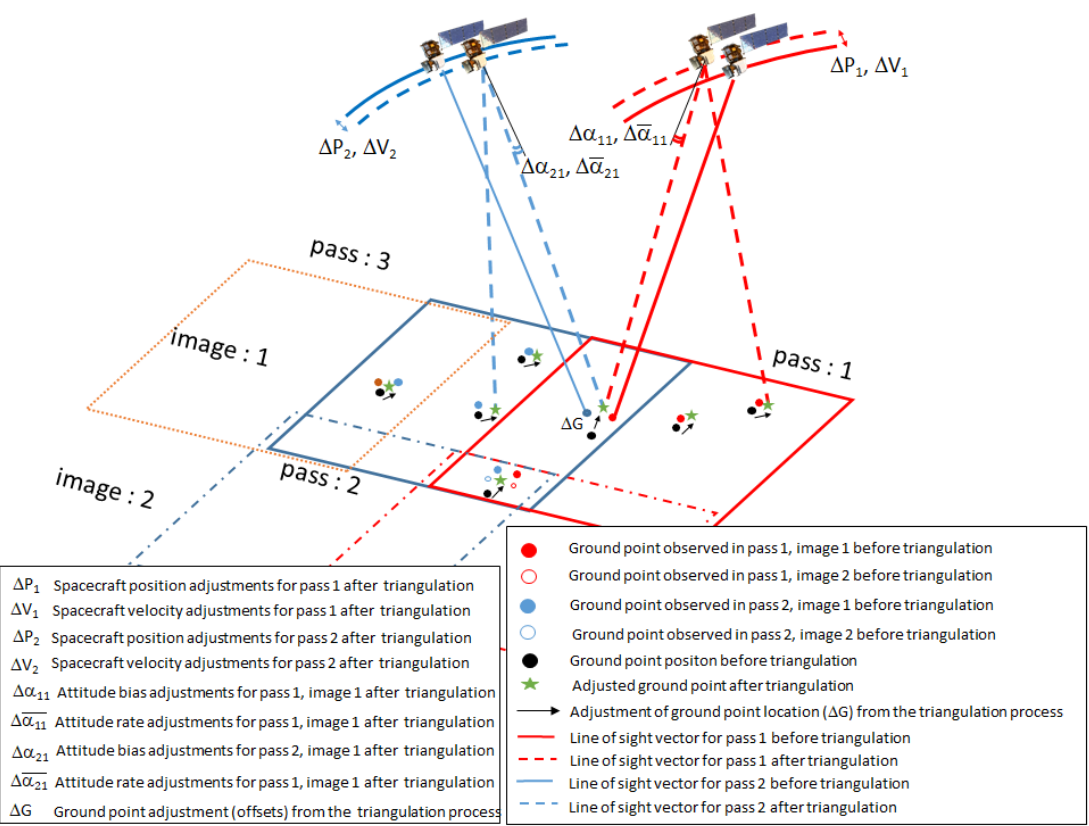
Figure 1. A pictorial representation of the space-based triangulation procedure. The orbital tracks prior to the triangulation for the two passes, pass 1 and pass 2, are shown in solid red and blue curves, respectively. The corresponding dotted lines (red, blue) denote the orbital track after the triangulation procedure. The solid red and blue line-of-sight vectors from the spacecraft to the ground represent the viewing geometry of a specific ground point observed in the image, prior to the triangulation process. The adjusted line-of-sight vectors to the ground point after the triangulation are denoted by dotted lines. The pre-triangulated positions of the ground points are shown in black dots, and their corresponding locations estimated from the spacecraft’s pre-adjustment attitude and ephemeris are shown by red and blue dots for pass 1 and pass 2, respectively. The same points in image 2 are shown as red and blue circles for passes 1 and 2, respectively. The green stars represent the triangulated positions of the ground points, and the black arrows indicate the positional offsets ( ∆ G ) for the ground points after